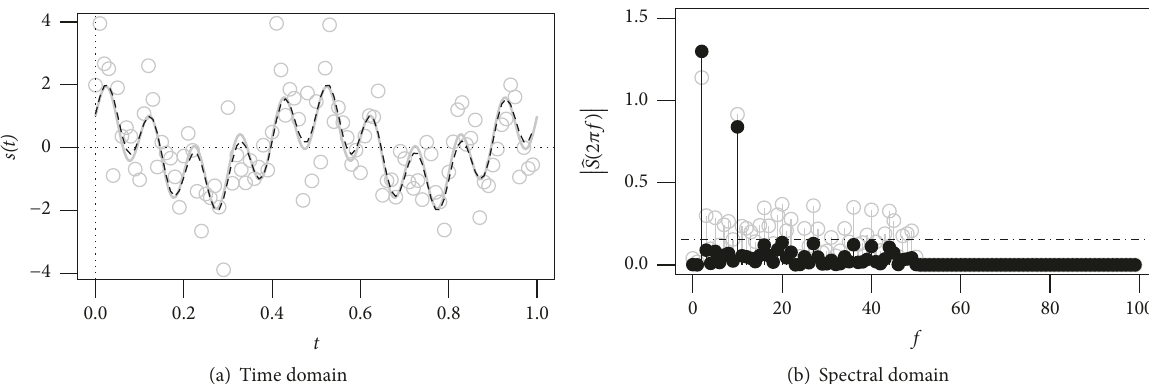
Figure 12: Noise reduction with autocorrelation. In the left panel (a) the sampled function (gray line) is overlaid with noise (circles). The bold line is the result of the weighted filtering procedure. In the frequency domain (b) the single sided spectra of the analytic functions are displayed. The input function (gray symbols) contains much noise which is reduced due to the autocorrelation (dotted black). The horizontal line indicates the threshold below which all spectral components are